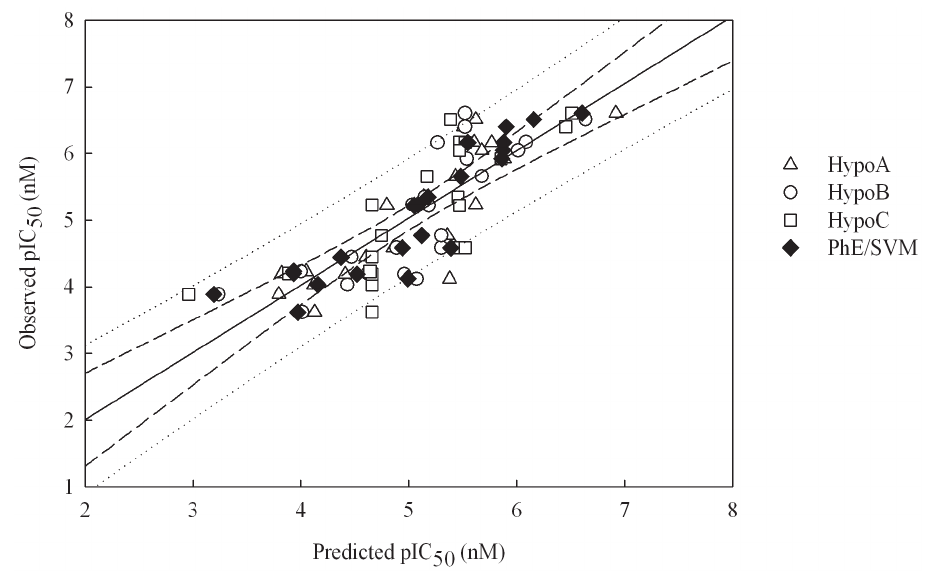
Figure 3. Observed vs . predicted pIC 50 values in the training set. Observed pIC 50 vs. the pIC 50 predicted by Hypo A, Hypo B, Hypo C, and PhE/ SVM for those molecules in the training set. The solid line, dashed lines, and dotted lines correspond to the PhE/SVM regression of the data, 95% confidence interval for the PhE/SVM regression, and 95% confidence interval for the prediction, respectively.